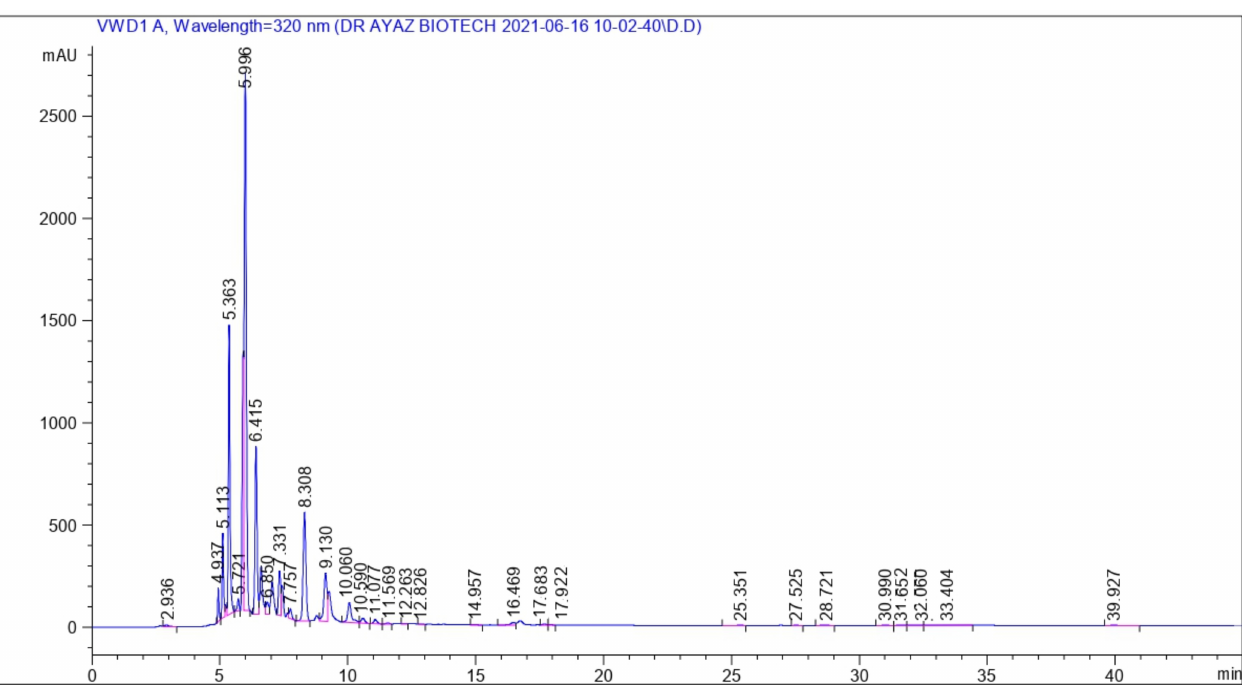
Figure 1. The HPLC chromatogram of flower methanolic extract of P . hysterophorous . The phenolic content of the methanolic extract of the flower of P. hysterophorus was 89,364 ± 4715 g GAE/g of extract, and the total flavonoid content was 65,022 ± 2694 g QE/g of extract.